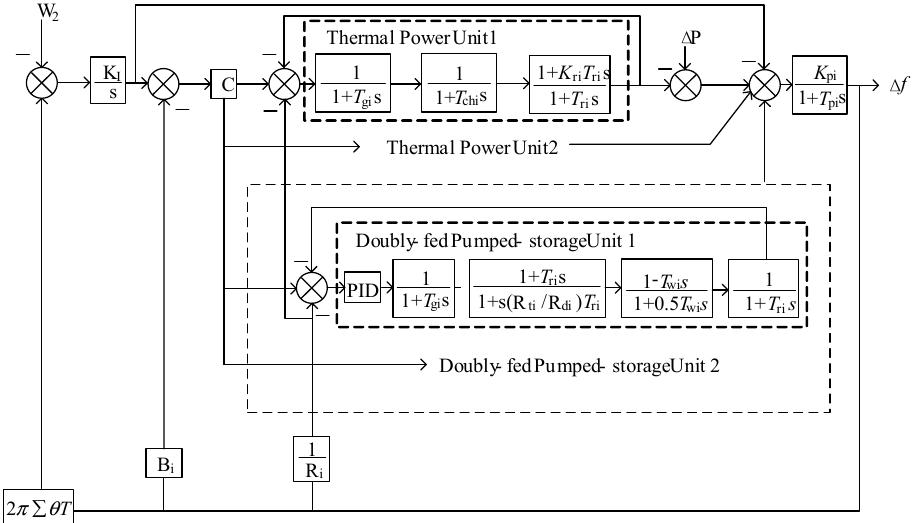
Figure 5. Joint frequency regulation control system diagram.